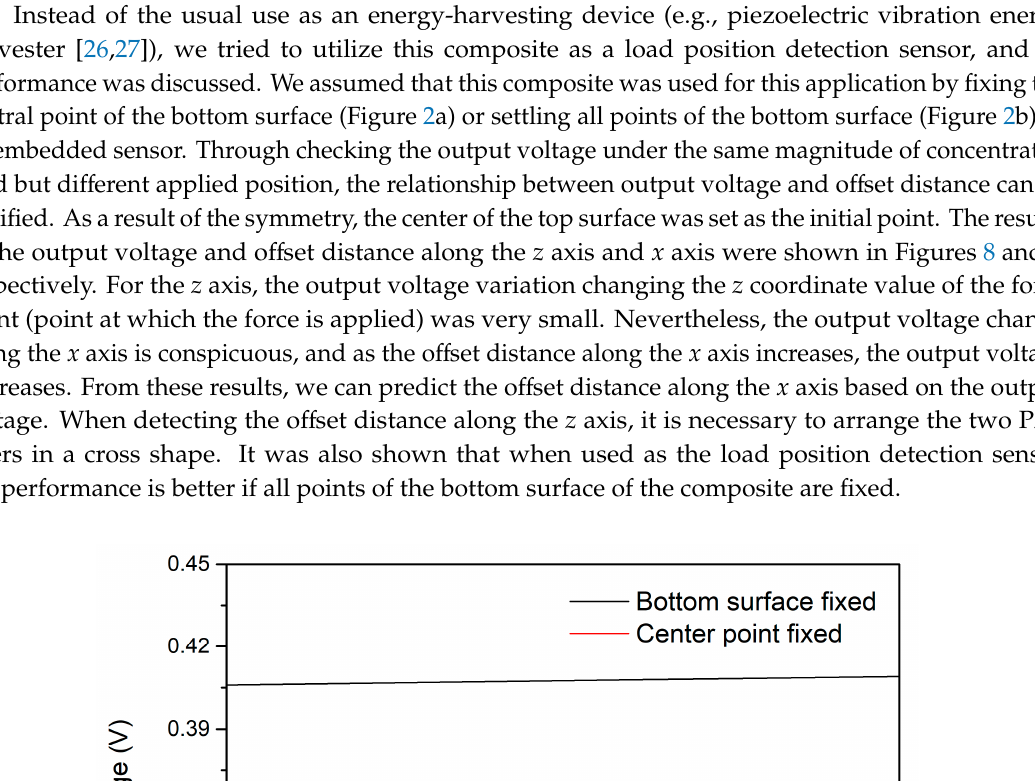
Figure 9. Relationships between the output voltage for the composite (Model 1) due to the concentrated load and the offset distance along the x axis ( z = 0 mm). Furthermore, the relationship between the compressive residual stress σ xx and distance d for the three models are also shown in Figure 10. The residual stresses of the three models all reached the peak value in the interface of the PZT fiber and Al matrix first, then decreased. Simultaneously, the residual stresses of Model 1 were larger than the other two models due to the symmetry. The higher the compressive residual stress, the better the piezoelectricity of the composite (see Figure 7). Therefore, it is desirable to embed the PZT fiber in the center of the Al plate as much as possible.